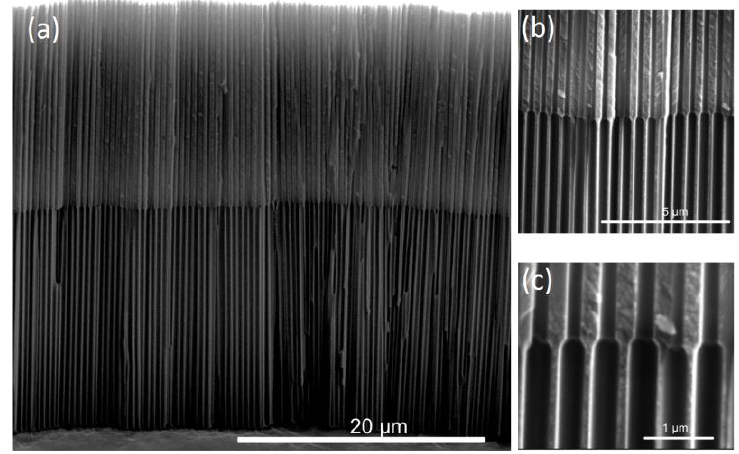
Figure 3. Cross section ESEM images of a two layered inverted funnel structure (IF2): ( a ) entire bilayer, ( b ) detail of the uniform pore growth, and ( c ) detail of the pore transition.